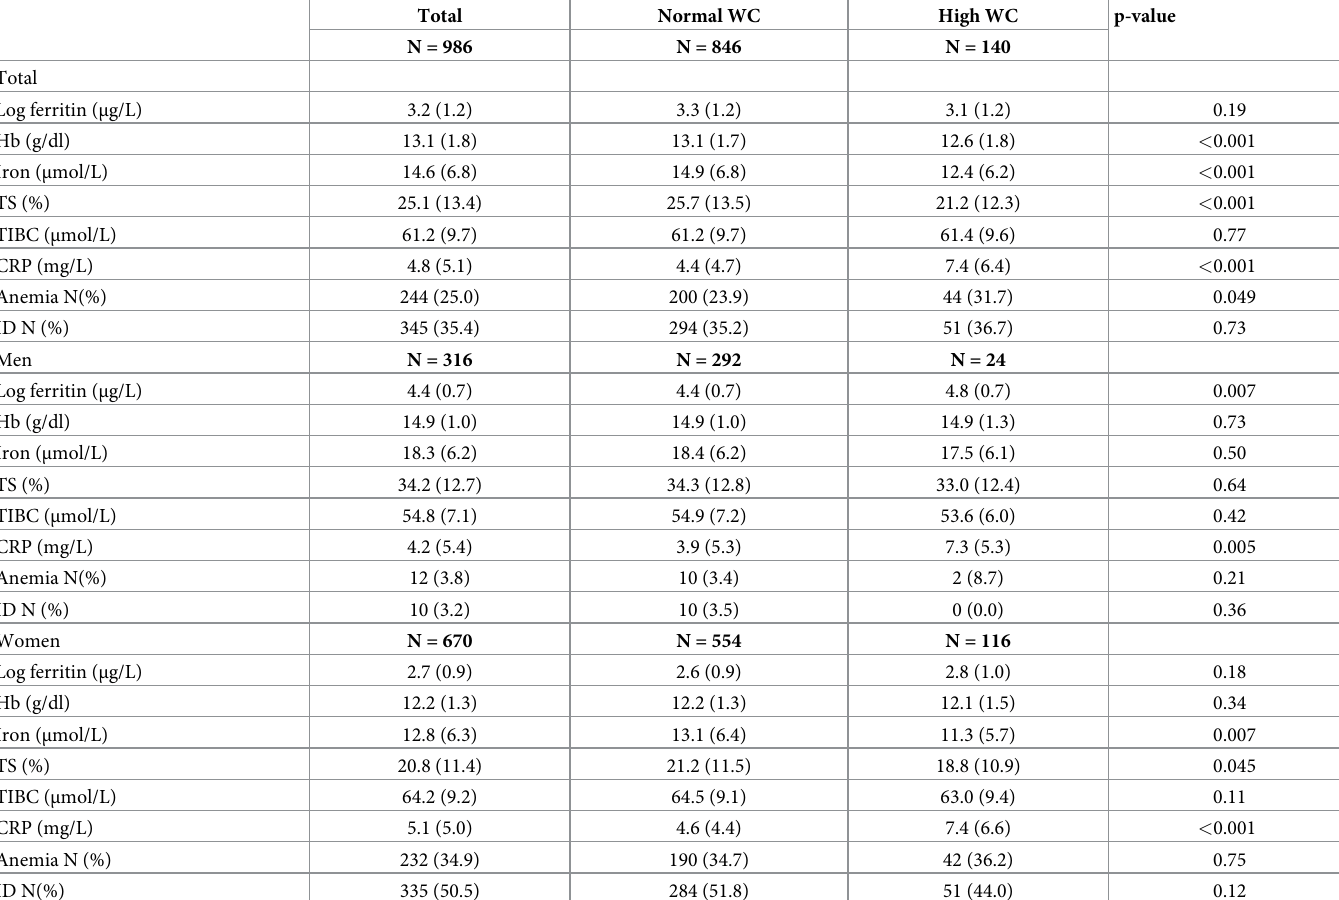
Table 2. Comparison of iron status indicators between people with normal and large